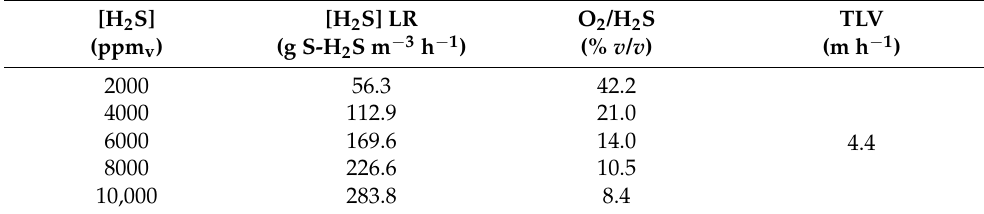
Table 1. Operational conditions for K L,H